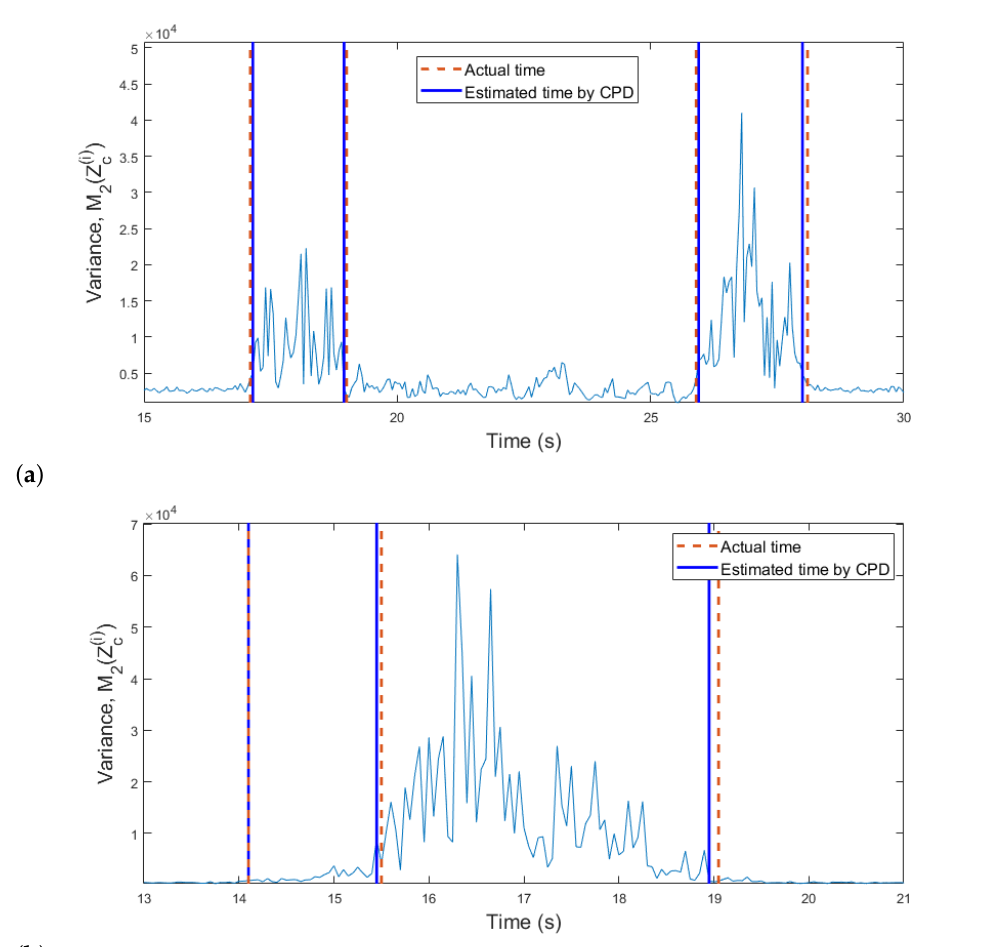
Figure 10. Boundary time between two motions estimated through the change point detection (CPD) algorithm: ( a ) From walking to standing, and then walking again. ( b ) From walking to crawling.